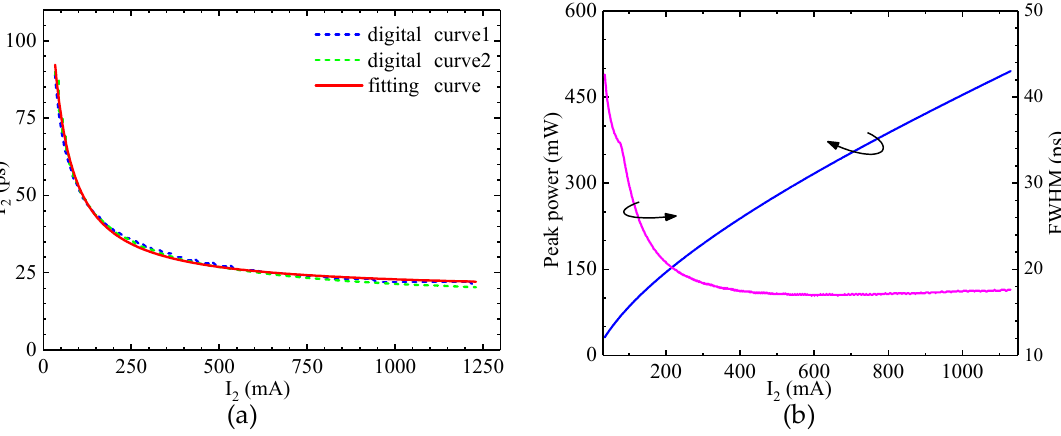
Figure 4. Simulation results of output pulses at different T 2 , when I 1 = 34 mA, T 1 = 0.971 ns, I 2 = 64 mA: ( a ) Time domain graph; ( b ) the peak power and full width at half maximum.